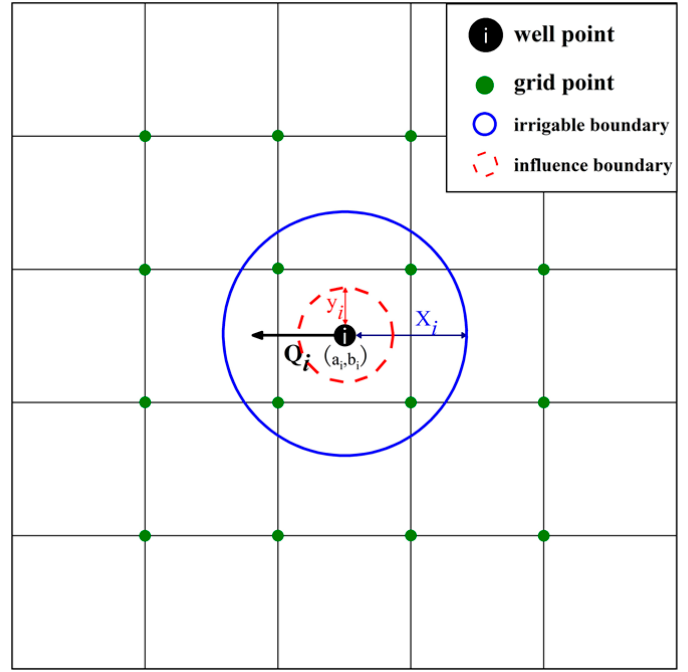
Figure 1.. Figure 1. Schematic diagram of a well location and grid